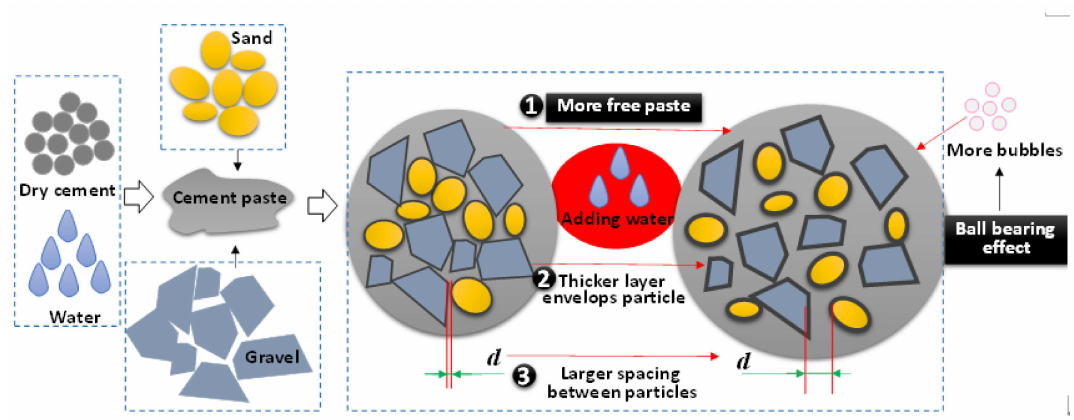
Figure 4. Schematic of the flowability change after increasing water